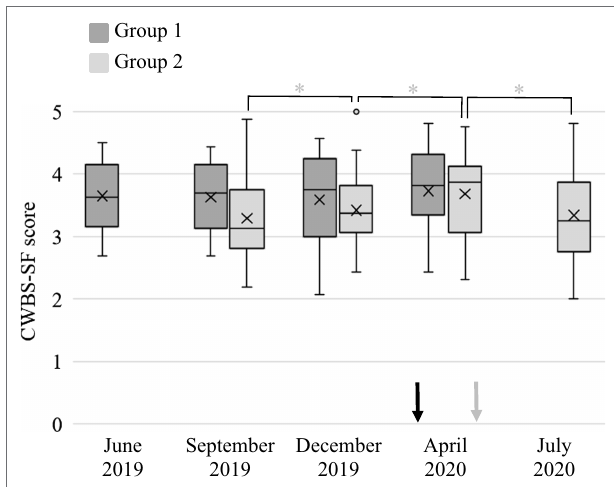
FIGURE 2 | Caregivers’ Well-Being Scale—Short Form (CWBS-SF) score of each group at each evaluation point. The box inferior limits represent first quartile of the distribution, and the upper limits the third quartile (median excluded). The lines across the box show the median score of each group. The crosses inside the boxes mark the mean value of each dataset. The whiskers indicate the minimum and maximum distribution values (outliers excluded). The dots above the upper and below the lower whiskers represent the distribution outliers identified through Tukey’s method (data points that lie above 1.5 times the interquartile range under the first quartile or over the third quartile). In June 2019, Group 1 was evaluated for the first time (T1). In September 2019, the second evaluation was conducted for Group 1 (T2), and the initial assessment occurred for Group 2 (T1). In December 2019, Group 1 was evaluated for the third time (T3) and Group 2 for the second time (T2). In April 2020, Group 1 was assessed for the last time (T4), and the third evaluation was conducted for Group 2 (T3). For Group 2, the last assessment occurred in July 2020 (T4). The black arrow indicates the initiation of the Italian COVID-19 national lockdown, and the grey arrow indicates its end for a total of 2 months. * p ≤